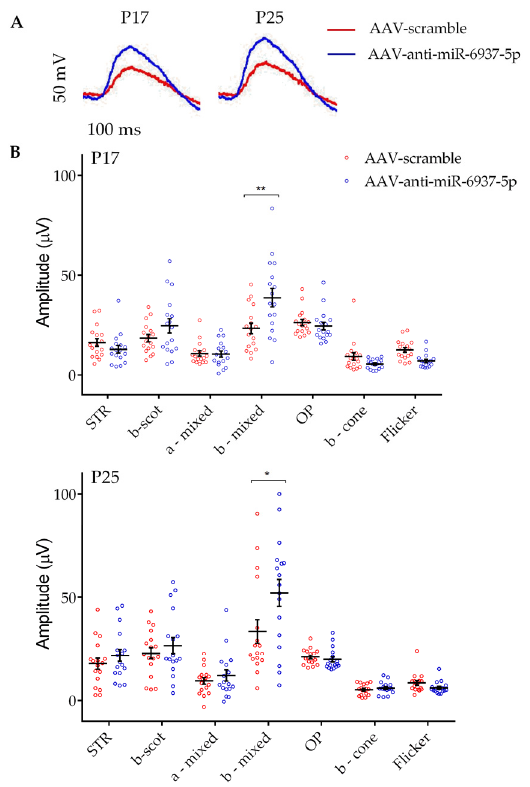
Figure 2. Increased amplitude of visual response in eyes treated with miR-6937-5p inhibitors. A. Representative electroretinogram (ERG) recordings of rd10 mice treated with miR-6937-5p inhibitor (blue) solution and eyes treated with scramble solution (red). ( A ) A significantly increased mixed response under scotopic conditions is shown, at both P17 and P25. ( B ) Representative scatter plots of different ERG parameters analyzed at both P17 and P25. N = 15 mice per treatment. Abbreviations: STR: scotopic threshold response; scot: scotopic; OP: oscillatory potential. Data are presented as mean values ± S.E.M. * p < 0.05, ** p < 0.01 (Student’s t -test).